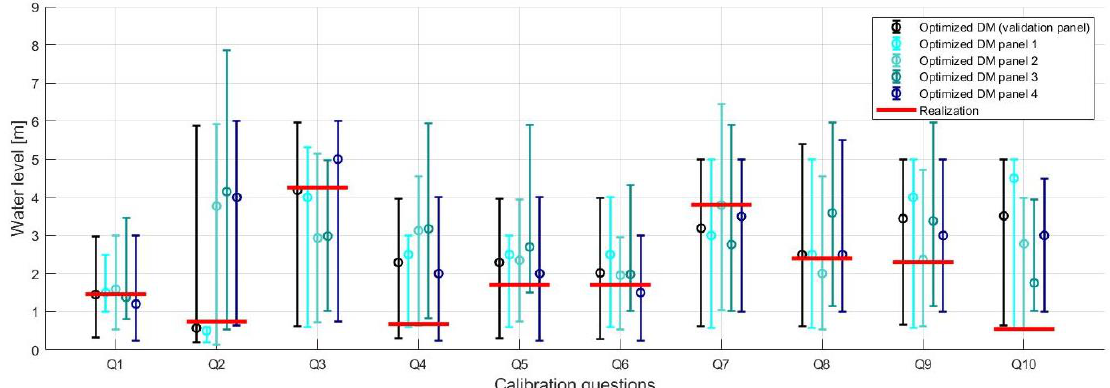
Figure 3. A comparison of the optimized Decision Makers of the different panels. The circles indicate the median estimate given by the optimized DM. The 5% and 95% quantiles are also given.